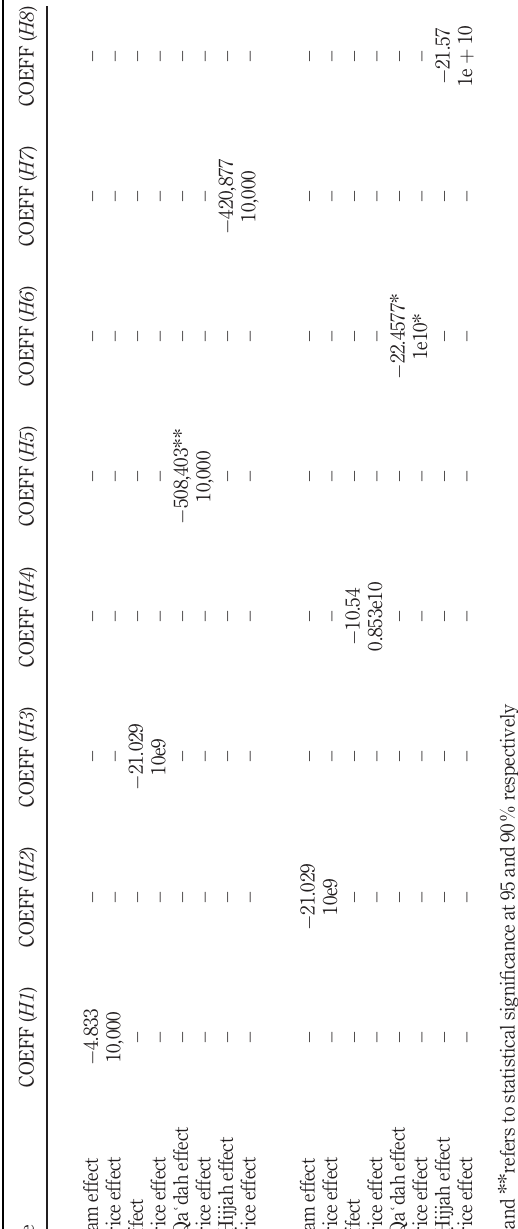
Table II. The estimation